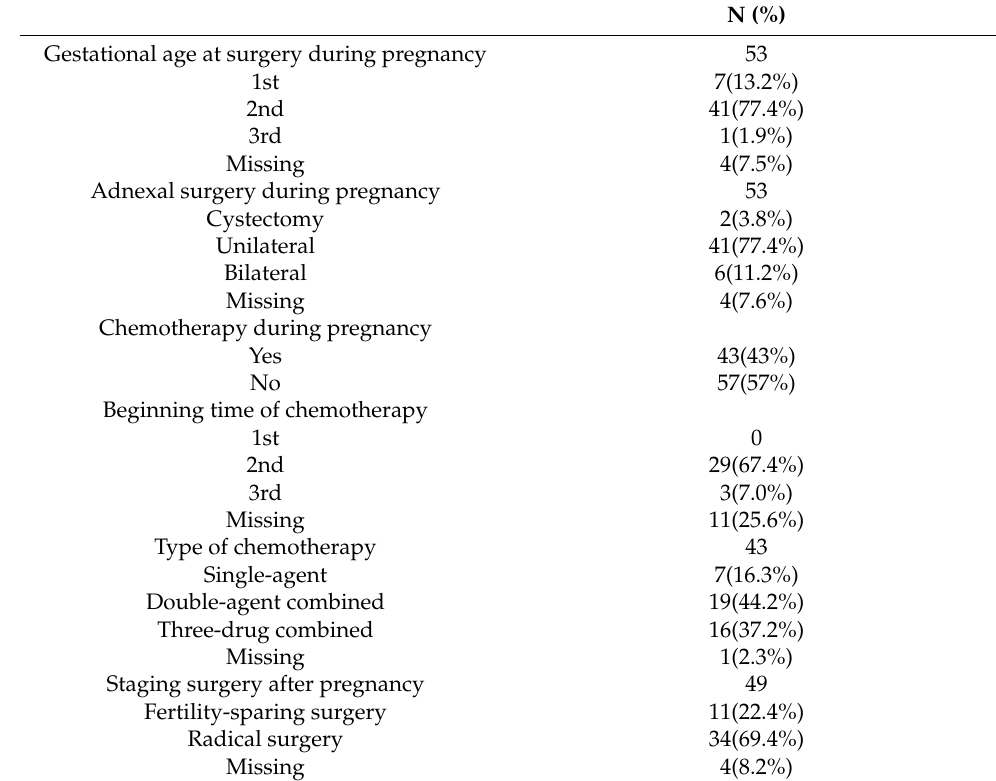
Table 3. Management of pregnant patients complicated with ovarian malignancy.